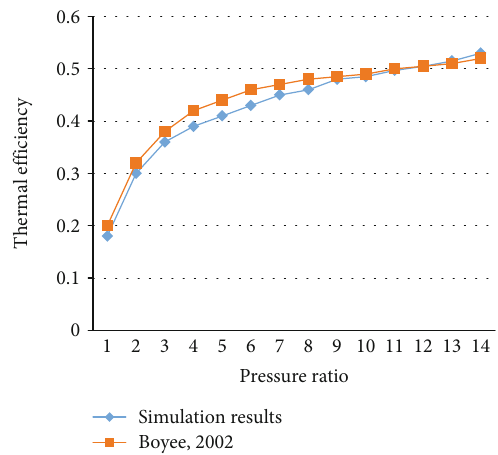
Figure 4: The relation of thermal e ffi ciency and pressure ratio of the simple GT and Boyce model.